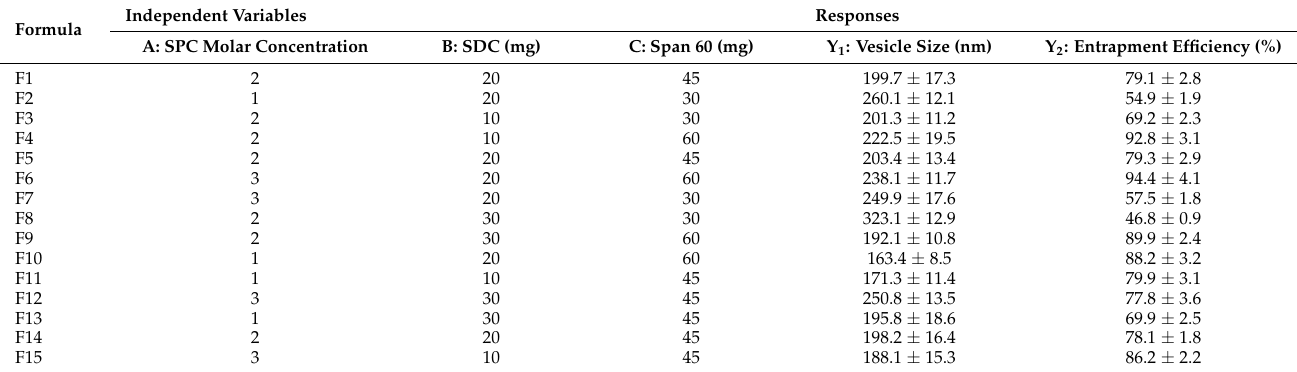
Table 2. Composition of SMV-BS and their physicochemical